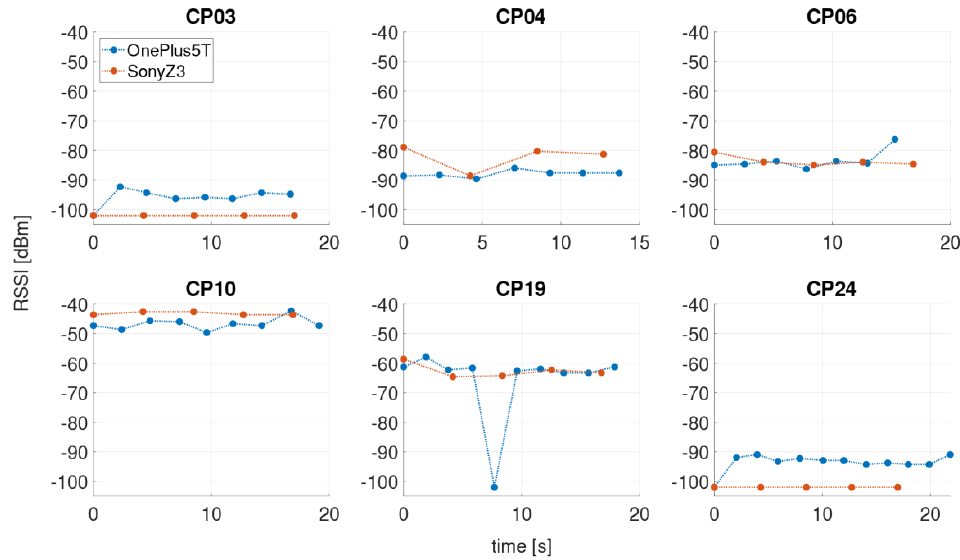
Figure 5. Zoomed views of the stopping phases for selected checkpoints for the two smartphones.